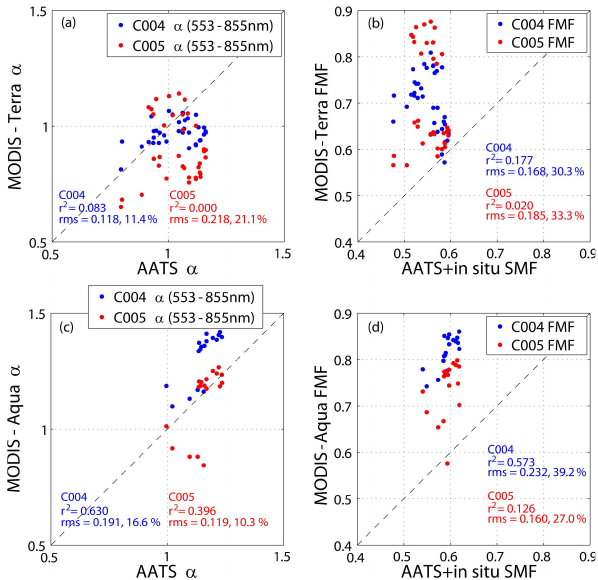
Fig. 14. (a) Comparison of MODIS-Terra and AATS-14 derived AOD Angstrom exponent for MODIS Collection 4 (C004, blue cir- cles) and Collection 5 (C005, red circles). (b) Same as (a), but for the MODIS-Terra derived fine mode fraction, FMF, versus the AATS + in situ derived sub-micron fraction of AOD. (c–d) same as (a–b), but for MODIS-Aqua. The AATS + in situ derived sub- micron fraction of AOD uses DC-8 INTEX-B measurements as de- scribed by Redemann et al.